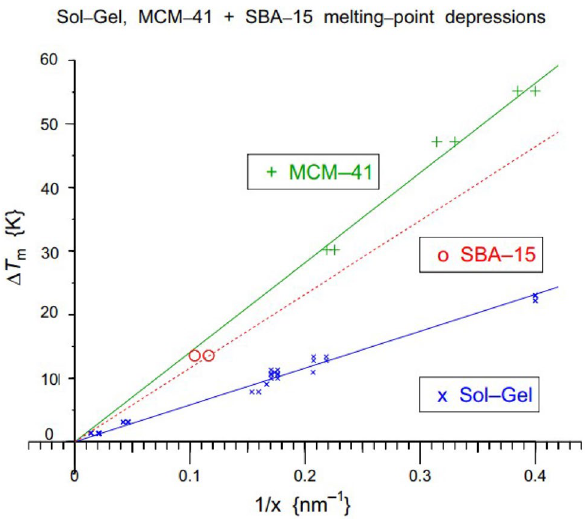
Fig. 21 The relation of melting point depression Δ Tm to inverse pore diameter x, for water in various sol–gel silicas as calibrated by gas adsorption measurements (x), compared with melting point depressions for water in templated cylindrical pores: MCM-41 (+) and SBA-15 (F5) (o). The dotted line has twice the slope as the fit to the sol-gel silica data